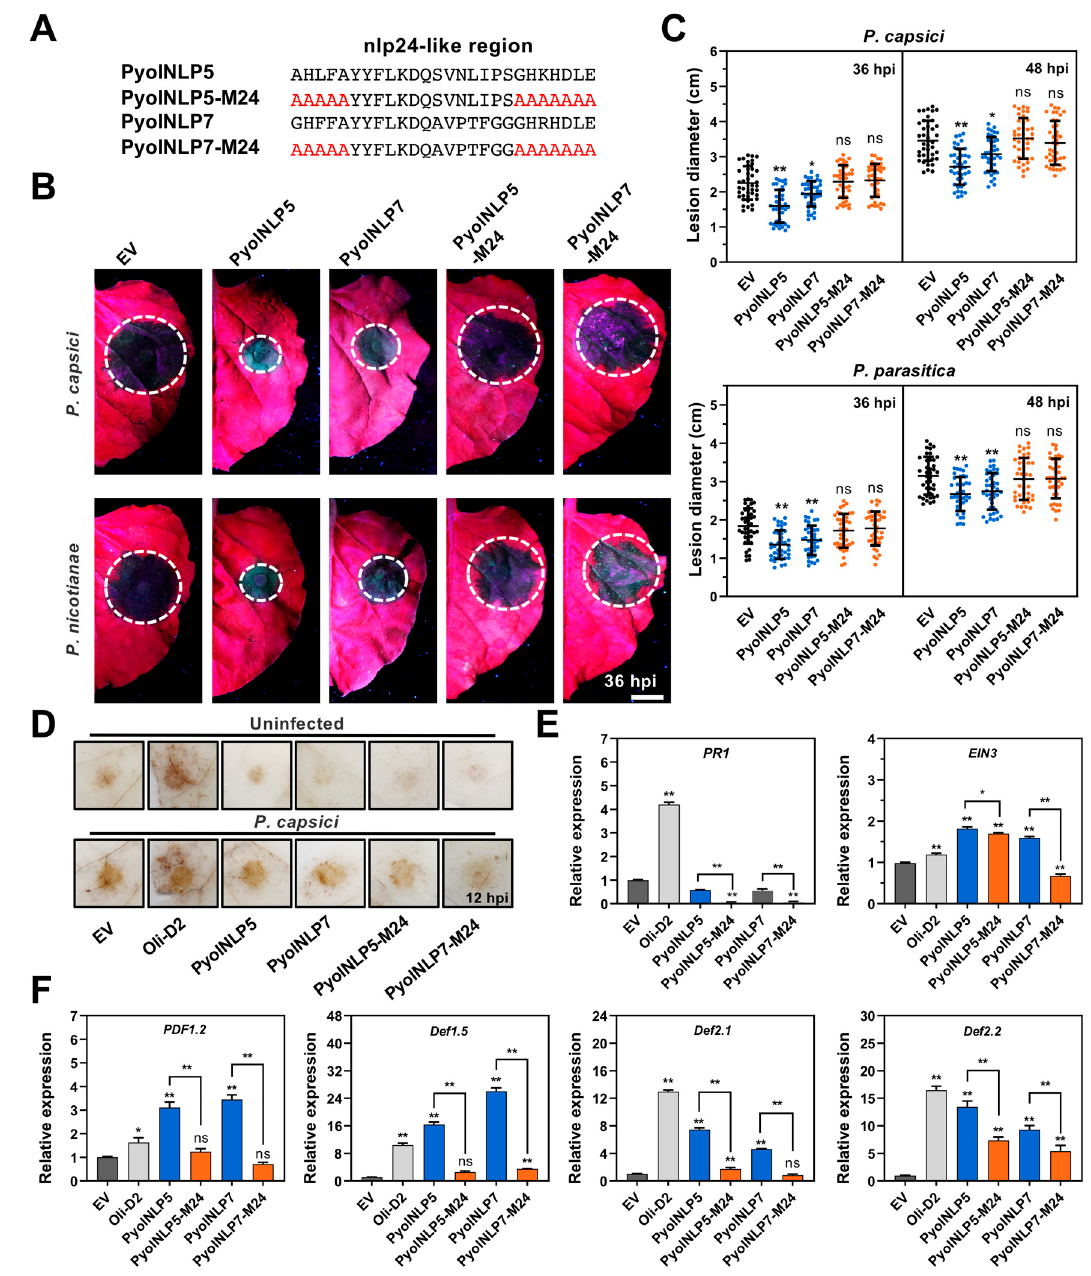
Figure 6. PyolNLP5 and PyolNLP7 suppress Phytophthora pathogen infection in Nicotiana benthamiana leaves via inducing plant defensin expression in an nlp24-dependent manner. ( A ) Schematic representation of nlp24 in PyolNLP5 and PyolNLP7 with introduced alanine substitutions. ( B ) Phenotypes of N. benthamiana leaves infiltrated with 200 nM PyolNLP5, PyolNLP7 or their nlp24 mutant proteins, and followed by P. capsici or P. nicotianae inoculation. Photos were taken at 36 hpi. Partially purified protein from EV with His-tag was used as a negative control. ( C ) Lesion diameters were measured by ImageJ. Data were analyzed from 40 biological repeats. ( D ) H 2 O 2 accumulation on N. benthamiana leaves infiltrated with partially purified PyolNLP5/7 or PyolNLP5/7-M24 mutant proteins. P. capsici was inoculated at 0 or 12 hpi. Oli-D2 acts as a positive control. DAB staining was performed at 12 hpi. ( E , F ) Relative expression levels of PR1 , EIN3 and plant defensins genes in N. benthamiana leaves infiltrated with partially purified PyolNLP5, PyolNLP7 or their mutant proteins. Partially purified His-tag protein acts as a negative control. Partially purified Oli-D2 acts as a positive control. Bar = 1 cm. Error bars represent the mean ± s.d. The results were analyzed by Median-edition Levene’s test to determine the homogeneity of variances across groups, and then analyzed by one-way ANOVA with a post hoc Tukey’s range test for groups with equal variances; *, p < 0.05; **, p < 0.01; ns, no significant differences. Experiments were repeated three times with similar results.